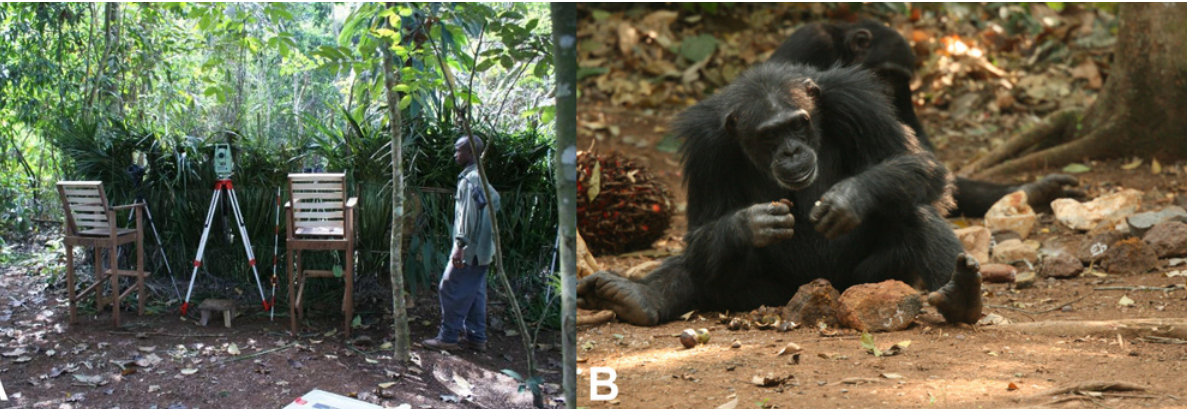
Fig 1. Bossou ‘ outdoor laboratory ’ . A) View of the experimental area in the Forest of Bossou, Guinea. Researchers record the nut-cracking behavior every year, using several video cameras while staying behind a screen of vegetation, c. 20m distance from the wild chimpanzees using tools. B) Female using a stone hammer and anvil to crack open nuts. Note the assortment of stones on the right side which is provided by the researchers, along with the piles of nuts.